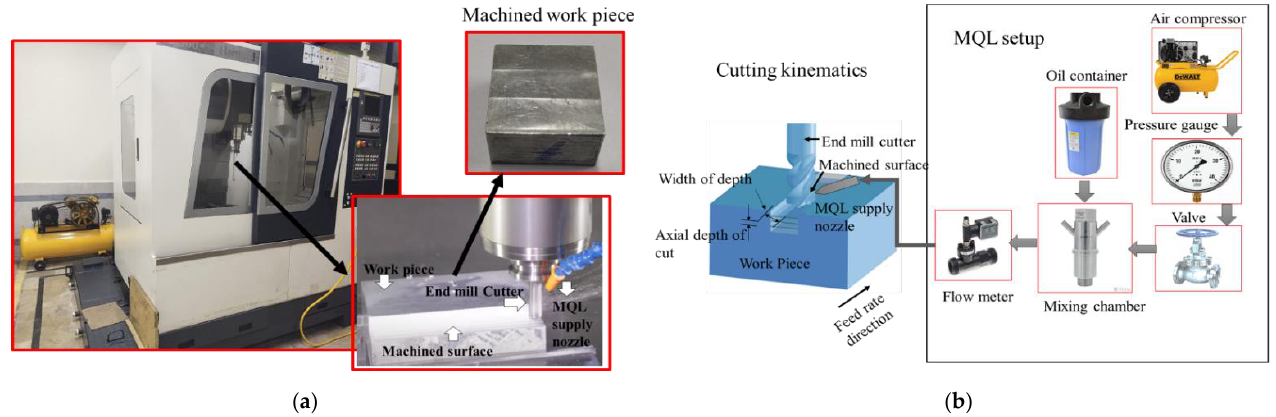
Figure 1. Experimental setup: ( a ) end milling of aluminum alloy, ( b ) schematic of cutting kinematics and MQL setup. Table 3. Selected machining parameters and levels.